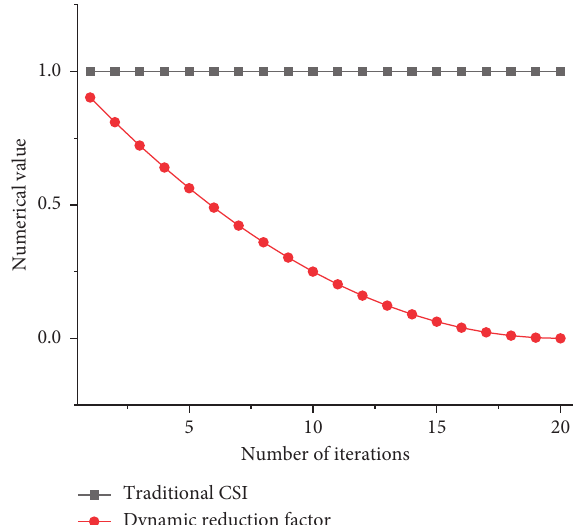
Figure 23: The comparison with the dynamic convergence factor.